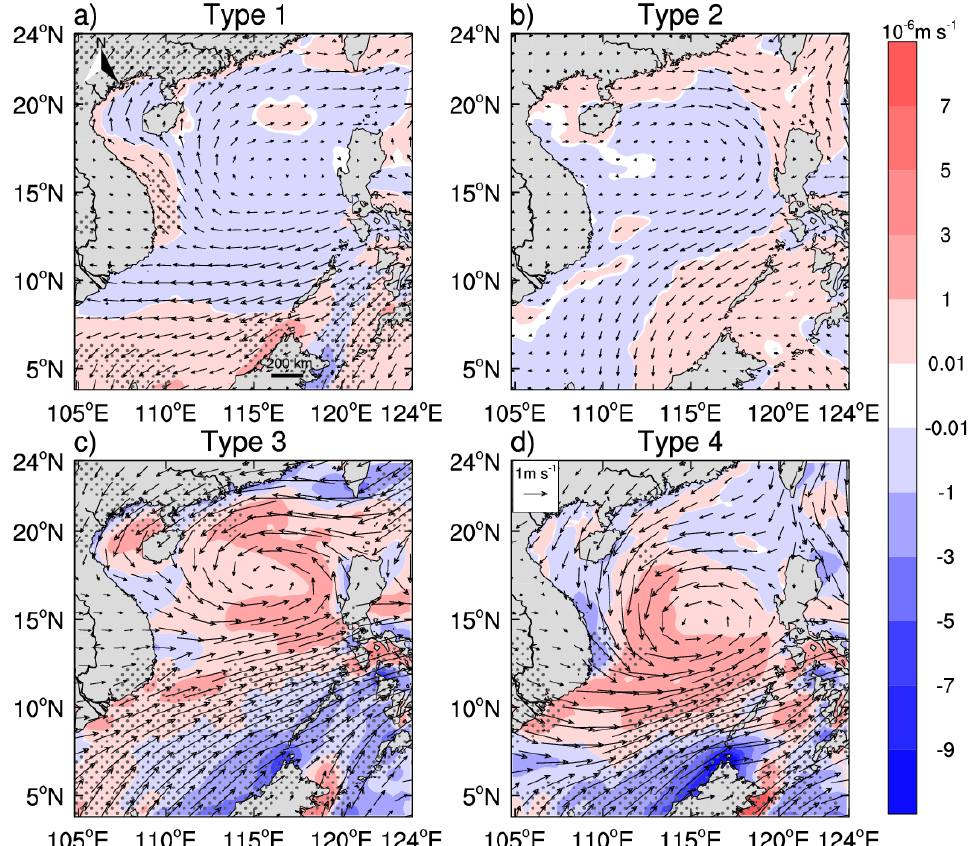
Figure 6. Wind field anomaly at 10 m (arrows) and the Ekman pumping velocity (shaded, positive value is upwelling) under the four synoptic types (the gray dots cover areas with significant differences): ( a ) Type 1; ( b ) Type 2; ( c ) Type 3; ( d ) Type 4.